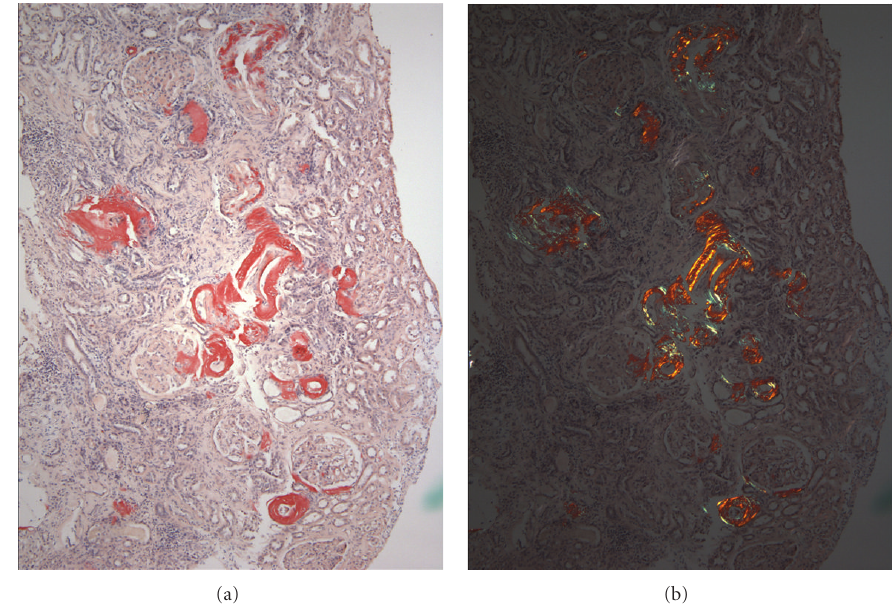
Figure 2: Congo red staining with red a ffi nity primarily in the wall of the vessels and in the interstitium (a). The same structures show green birefringence on polarized light (b).